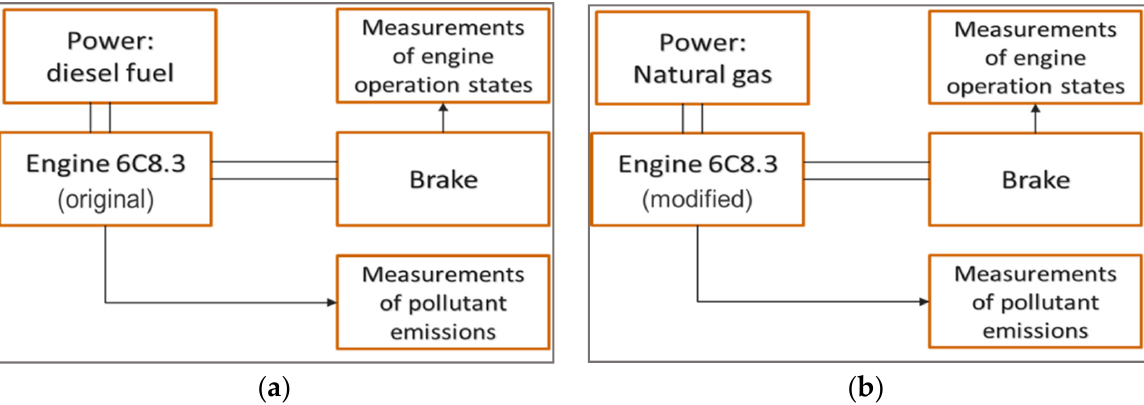
Figure 3. Scheme of the test bench with the tested engines: ( a ) original Cummins 6C8.3 engine, and ( b ) modified Cummins 6C8.3 engine.